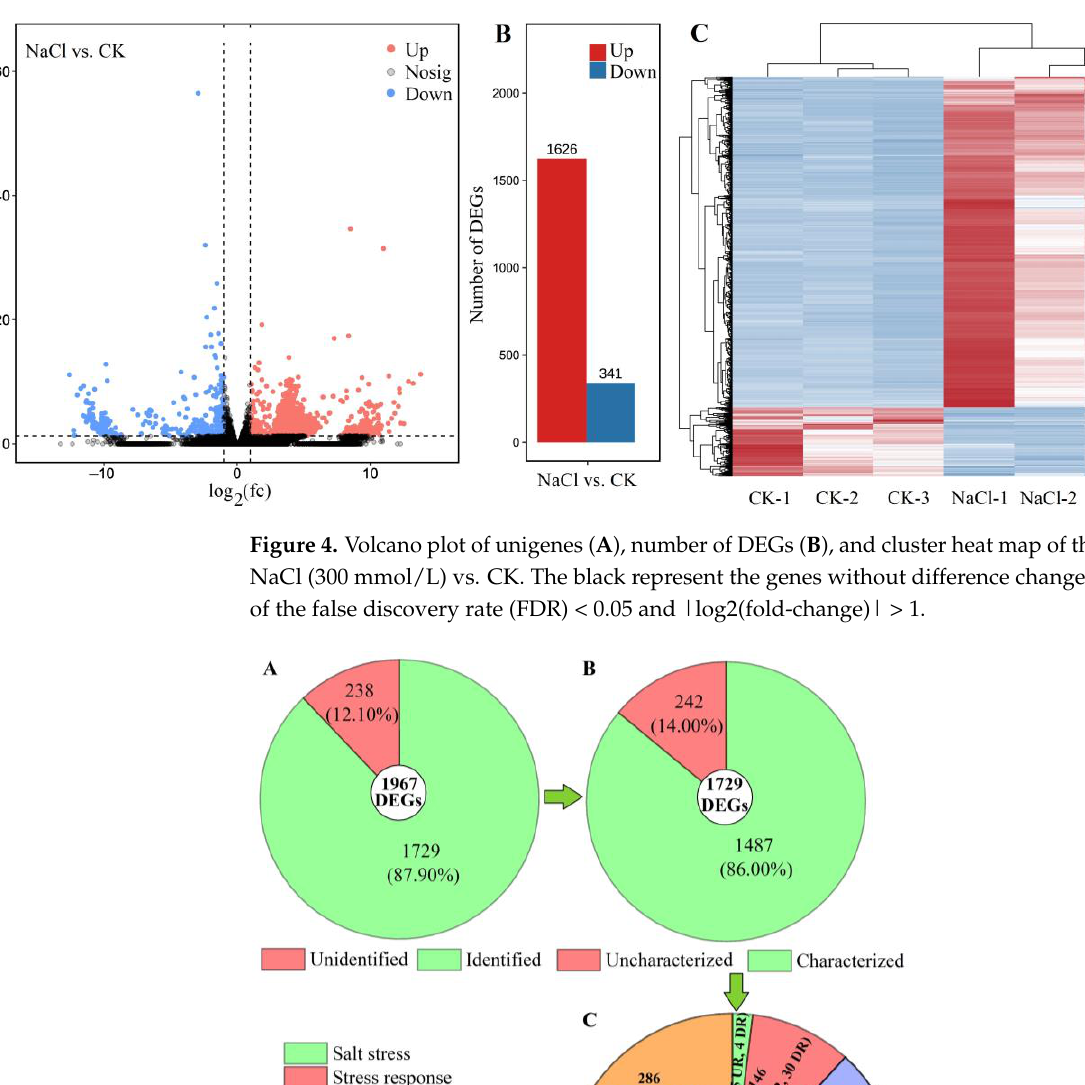
Table 2. Twenty-nine genes directly associated with salt stress at 300 mmol/L NaCl vs. CK. Gene Name